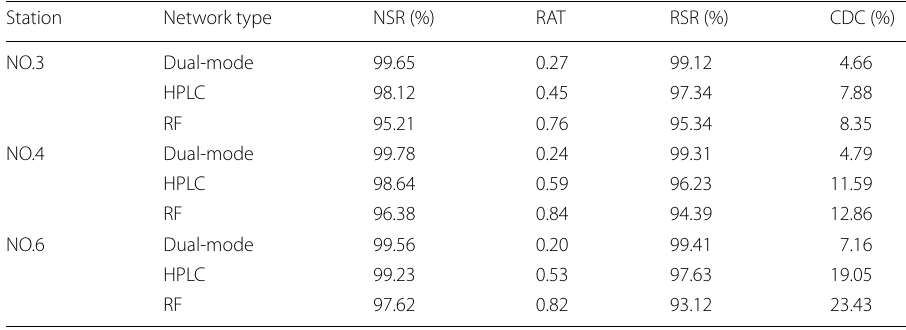
Table 4 Test data of three kinds of field network in jobsite